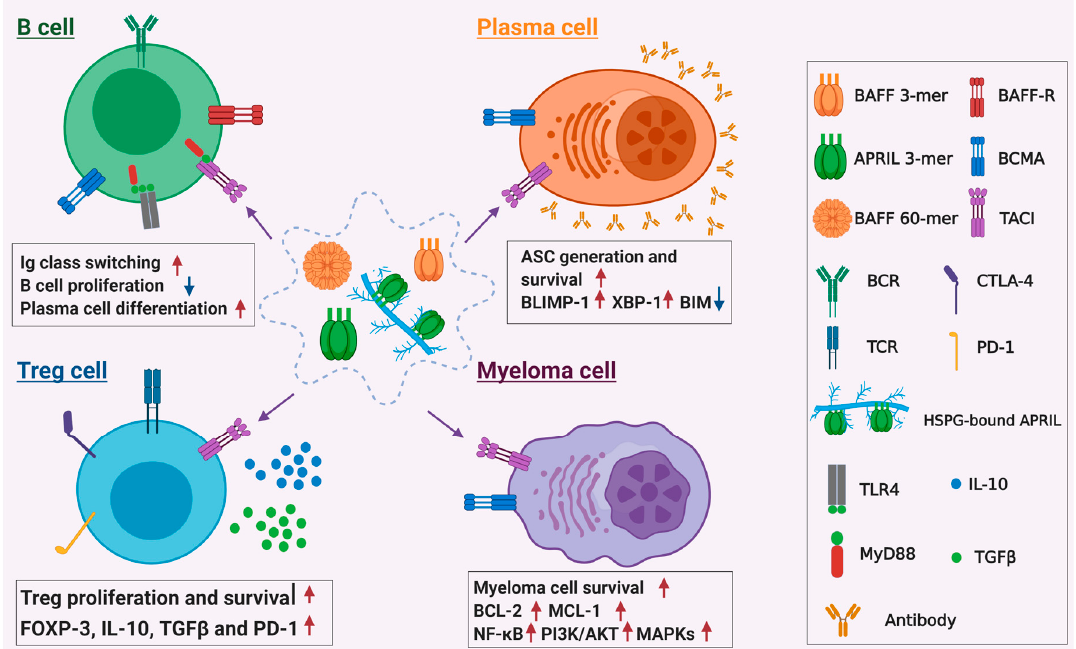
Figure 2. Role of TACI in B cell physiology and MM pathophysiology. For normal B cells, TACI regulate Figure 2 immunoglobulin class switching upon engagement by BAFF or APRIL. It transduces the activation signals via interacting with adaptor protein MyD88 and cooperates with signaling through TLRs, such as TLR4, to promote immunoglobulin class switching. TACI can also regulate plasma cell di ff erentiation and survival by upregulating transcriptional factors Blimp-1 and XBP-1 and downregulating pro-apoptotic protein Bim. For pathogenesis of MM, TACI mediates the signals of BAFF and APRIL to activate multiple downstream signaling pathways, including NF- κ B, PI3k / Akt, and MAPKs pathways, leading to upregulation of anti-apoptotic proteins BCL-2 and MCL-1, which enhance MM cell survival. TACI- mediated signaling can also support immunosuppressive tumor microenvironment in the bone marrow of MM patients by promoting the survival of regulatory T cells and their inhibitory